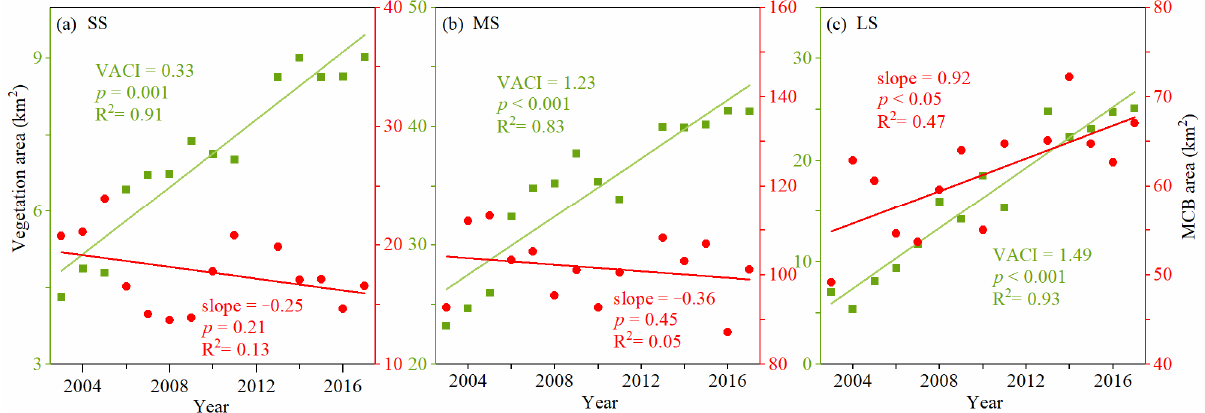
Figure 7. Changes in vegetation area (in green) and MCB area (in red) of three types of MCBs. ( a ) For small-sized MCBs (SS), ( b ) for middle-sized MCBs (MS), ( c ) for large-sized MCBs (LS). The slope parameter represents the change trend of the MCB area. The VACI parameter represents the change trend of the MCB vegetation area.